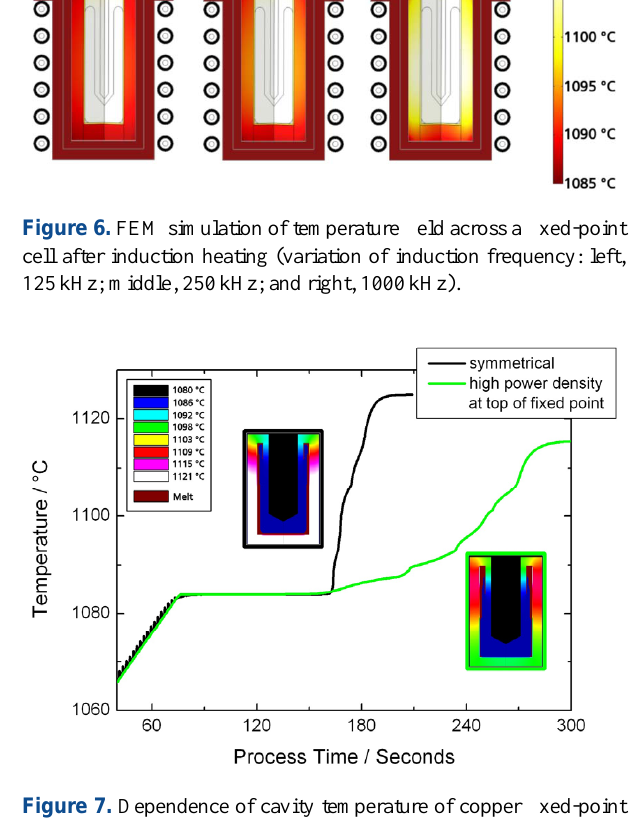
Figure 7. Dependence of cavity temperature of copper fixed-point cell on distribution of the induction heat sources, and the result of FDM simulation. Thermal images show the temperature field during the melting plateau.